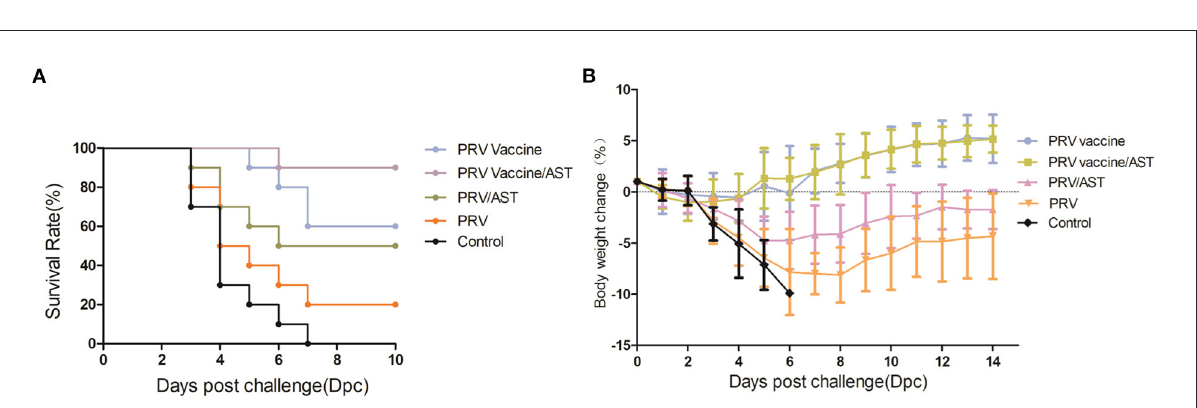
FIGURE4 Survival rate and body weight changes of mice after challenge. Mice in different groups were challenged with PRV at 28 dpi, and the survival rate and body weight changes of the mice were analyzed from dpc 0 to dpc 14. Body weight changes of mice in different groups after challenge (A) . Survival rates of mice in different groups after challenge (B) . Data are the means ± S.D. ( n = 10).